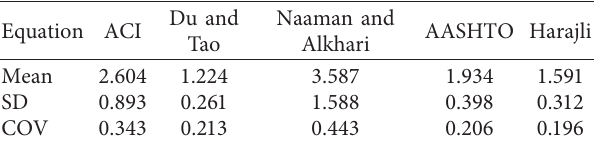
Table 5: Statistical data obtained from the comparison between experimental tendon stresses by the test results and existing